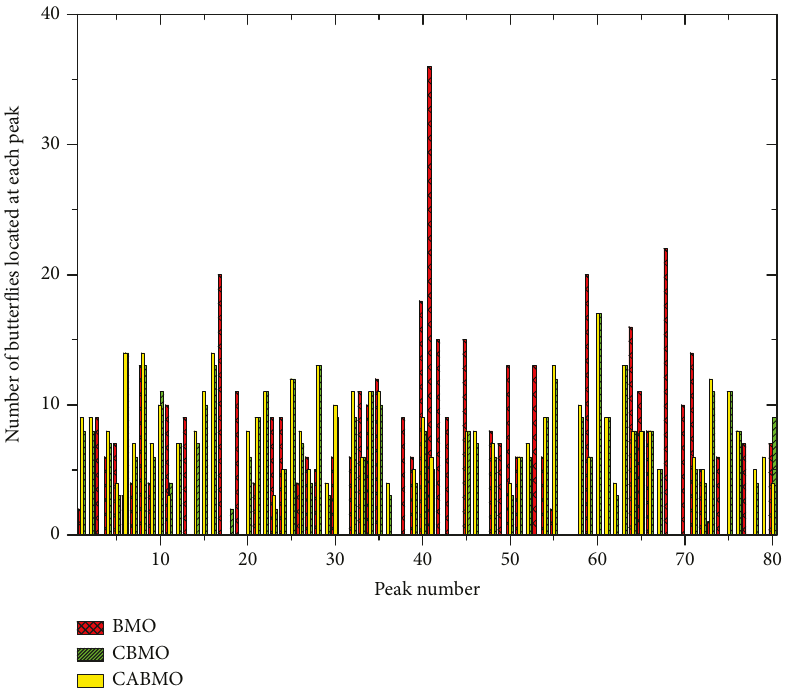
Figure 4: Number of butter fl ies located at each peak of the function f